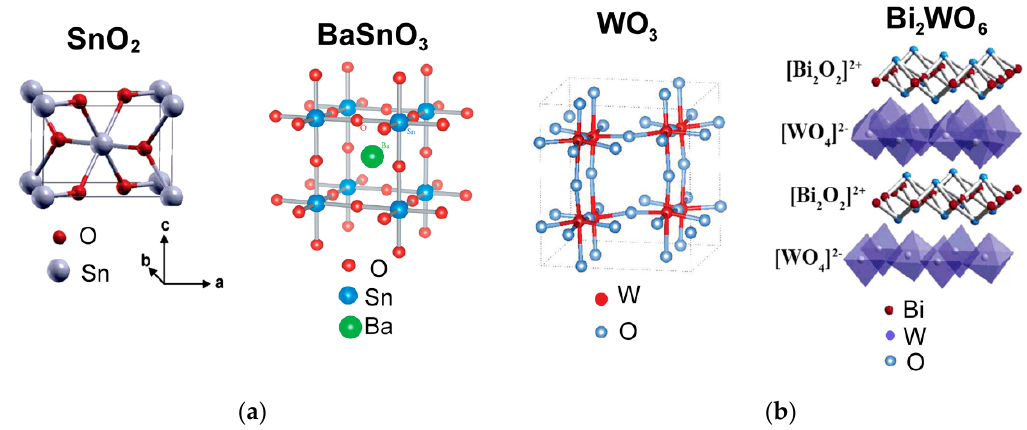
Figure 16. Unit cells of rutile-like tetragonal SnO 2 , perovskite-like cubic BaSnO 3 ( a ), monoclinic WO 3 and Aurivillius structure of Bi 2 WO 6 ( b ). Adapted with permissions from references [61,63,113]. Copyrights 2013 American Physical Society, 2021 Elsevier, 2014 Elsevier.